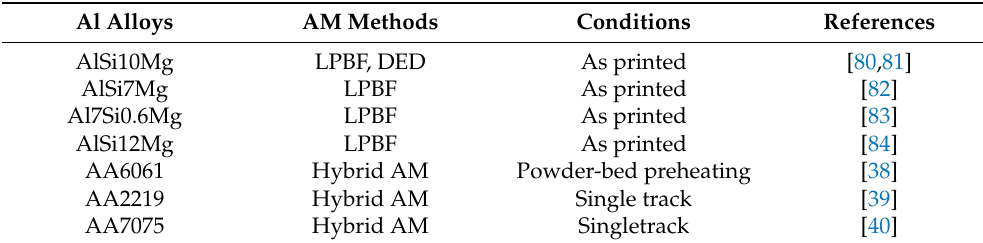
Table 3. Printable Al alloys and their corresponding AM methods.